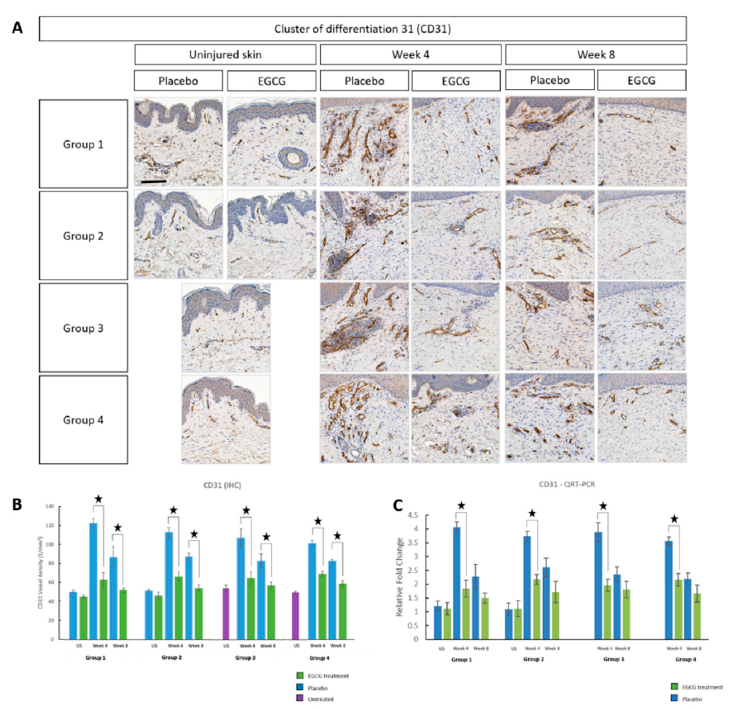
Figure 17. Angiogenesis marker CD31 analysis of topical epigallocatechin-3-gallate (EGCG) versus placebo. ( A ) Cluster of differentiation 31 (CD31) images demonstrated a reduction in vessel density in EGCG samples compare to placebo. ( B ) CD31 vessel density measurements. ( C ) Quantitative real-time reverse transcriptase–PCR (QRT-PCR) analysis for CD31. Significance: ★ p ≤ 0.01. Error bars: mean ± SD. Scale bars = 50 μ m.